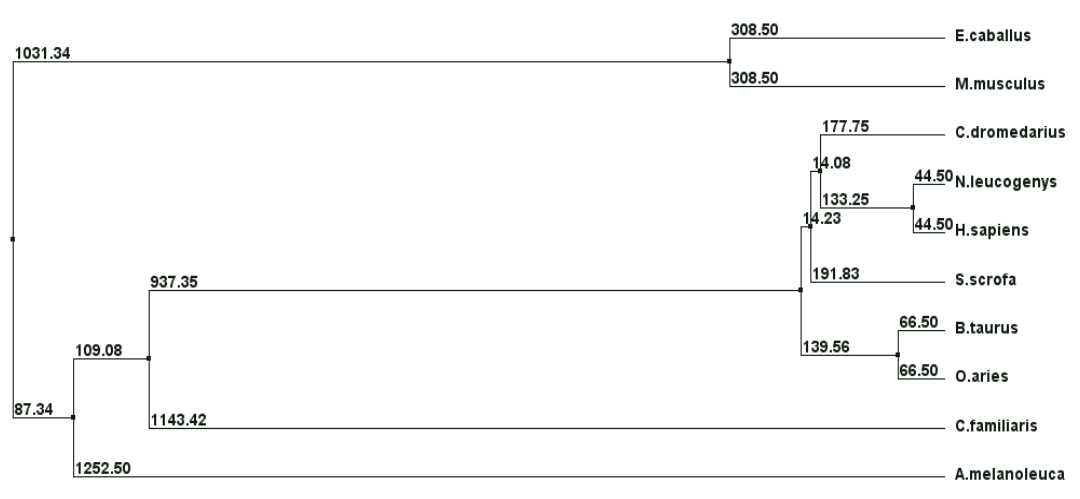
Figure 4. The phylogenetic tree of cLIPA and similar proteins from the Genbank database. The alignment was generated with the BLOSUM62 from MAFFT Multiple Sequence Alignment and Jalview [18,19].